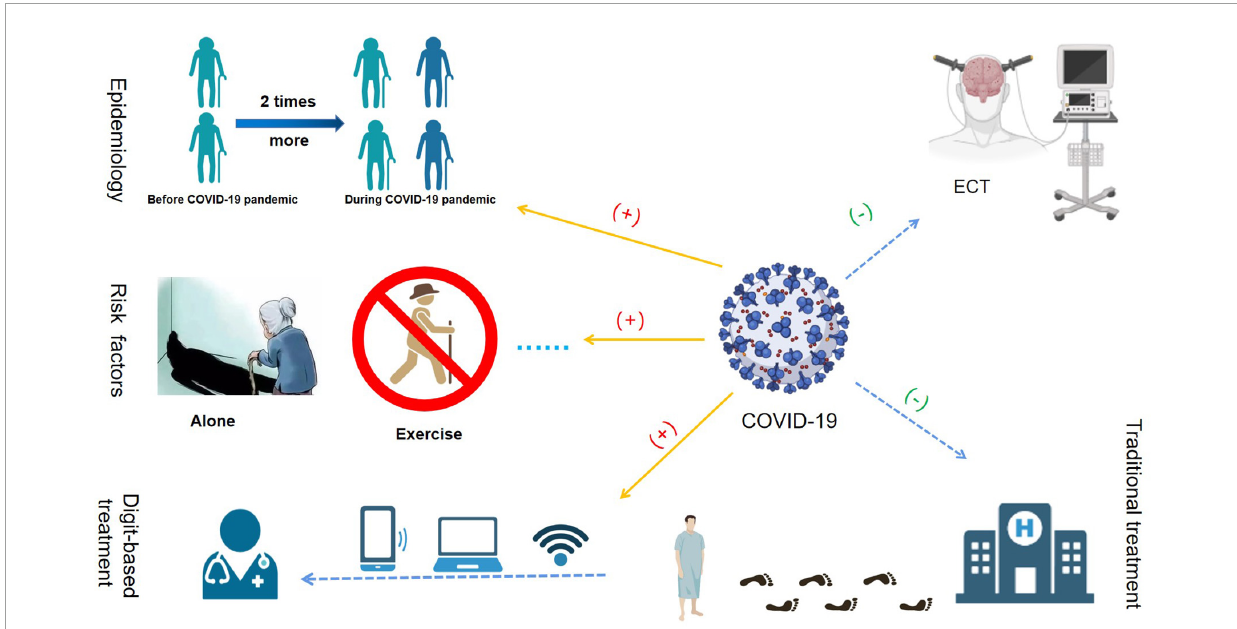
FIGURE1 The effects of the COVID-19 pandemic on late-life depression (LLD). The COVID-19 pandemic increased the prevalence of LLD significantly. The prevalence of clinically significant depressive symptoms during the COVID-19 pandemic, which was more than two times higher than before the COVID-19 pandemic. The main risk factors associated with LLD during the COVID-19 pandemic were female sex, loneliness, poor sleep quality, and poor motor function. During the COVID-19 pandemic, owing to the possibility of virus transmission via bag-mask ventilation in the electroconvulsive therapy (ECT) procedure, many ECT units in hospitals worldwide were closed. During the COVID-19 pandemic, the conventional medical and healthcare service mode was “devastating,” while modern digital health intervention technology developed